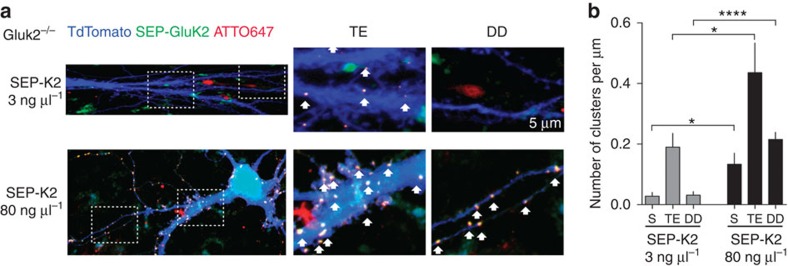
Subcellular distribution of SEP–GluK2a in CA3 PCs.(a) Sample images illustrating CA3 neurons electroporated with 3 ng μl−1 (top) or 80 ng μl−1 (bottom) SEP–GluK2 cDNA (green), TdTomato (blue) and live stained for the SEP moiety using anti-GFP nanobody-ATTO647 (red). Representative confocal z-stack projections are shown for each condition. Insets represent characteristic CA3 TEs or DDs. Arrows show the co-localized SEP and anti-GFP nanobody signals that correspond to SEP–GluK2 clusters. (b) Average number of clusters per unit length at the soma (S), TE or DD for each condition (3 ng μl−1: n=11 cells, 3 different experiments, 3 mice; 80 ng μl−1: n=10 cells, 3 different experiments, 3 mice). In all panels, values are presented as mean ±s.e.m. of n experiments. Data were compared using unpaired t-test (*P<0.05 and ****P<0.0001).